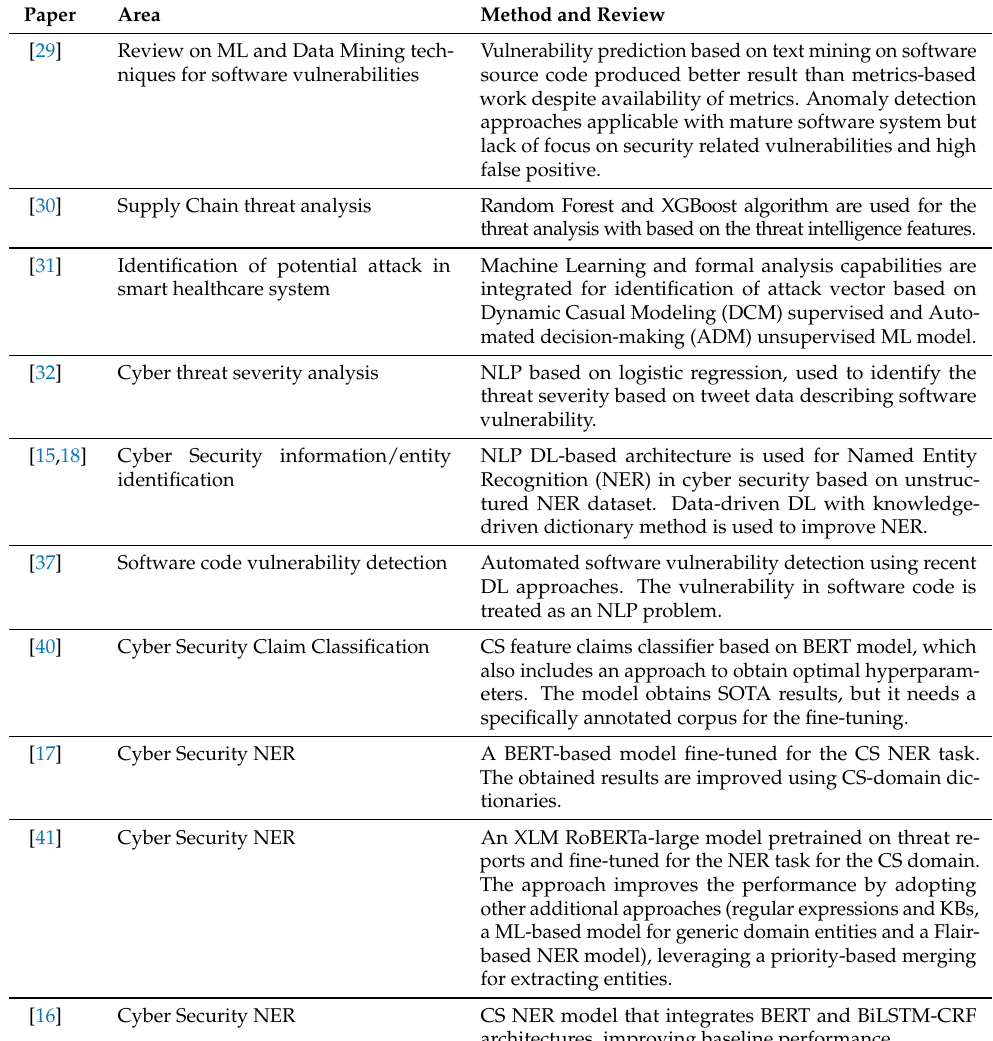
Table 1. Summary of ML models available in the literature for threat and vulnerability